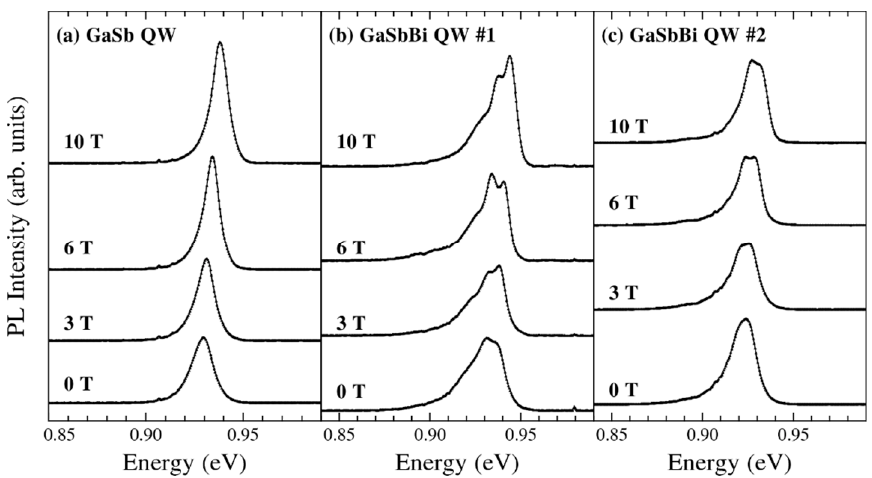
Figure 19. PL spectra of GaSb quantum well (QW) and GaSbBi QW in various magnetic fields. The detailed PL features in GaSbBi QW are present. A detailed PL feature being located at a higher energy than the effective bandgap of GaSb QW is shown in GaSbBi QW #2.